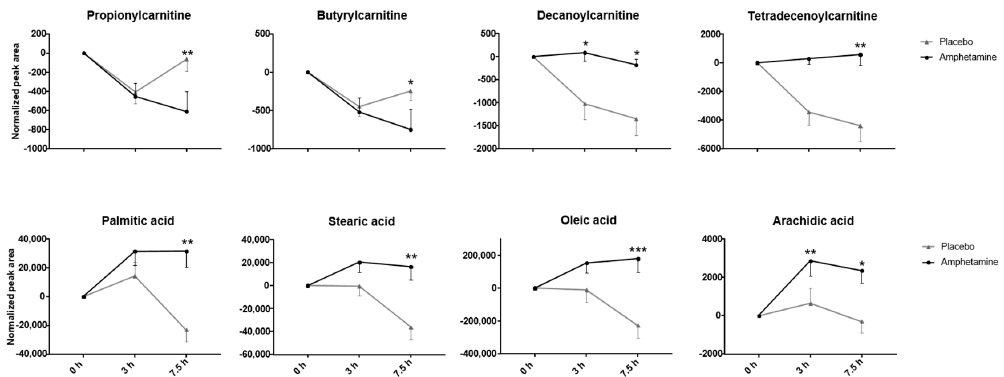
Figure 3. Influence of amphetamine on di ff erent short- and medium-chain acyl carnitines (upper panel) and long-chain fatty acids (lower panel). Black lines indicate drug, light grey lines placebo intake, respectively. Data points represent mean and standard error of mean (SEM) of 13 replicates. Statistical comparison was performed between placebo and drug intake using paired t -tests ( p < 0.05; n.s. > 0.05; * 0.01–0.05; ** 0.001–0.01; *** 0.0001–0.001).